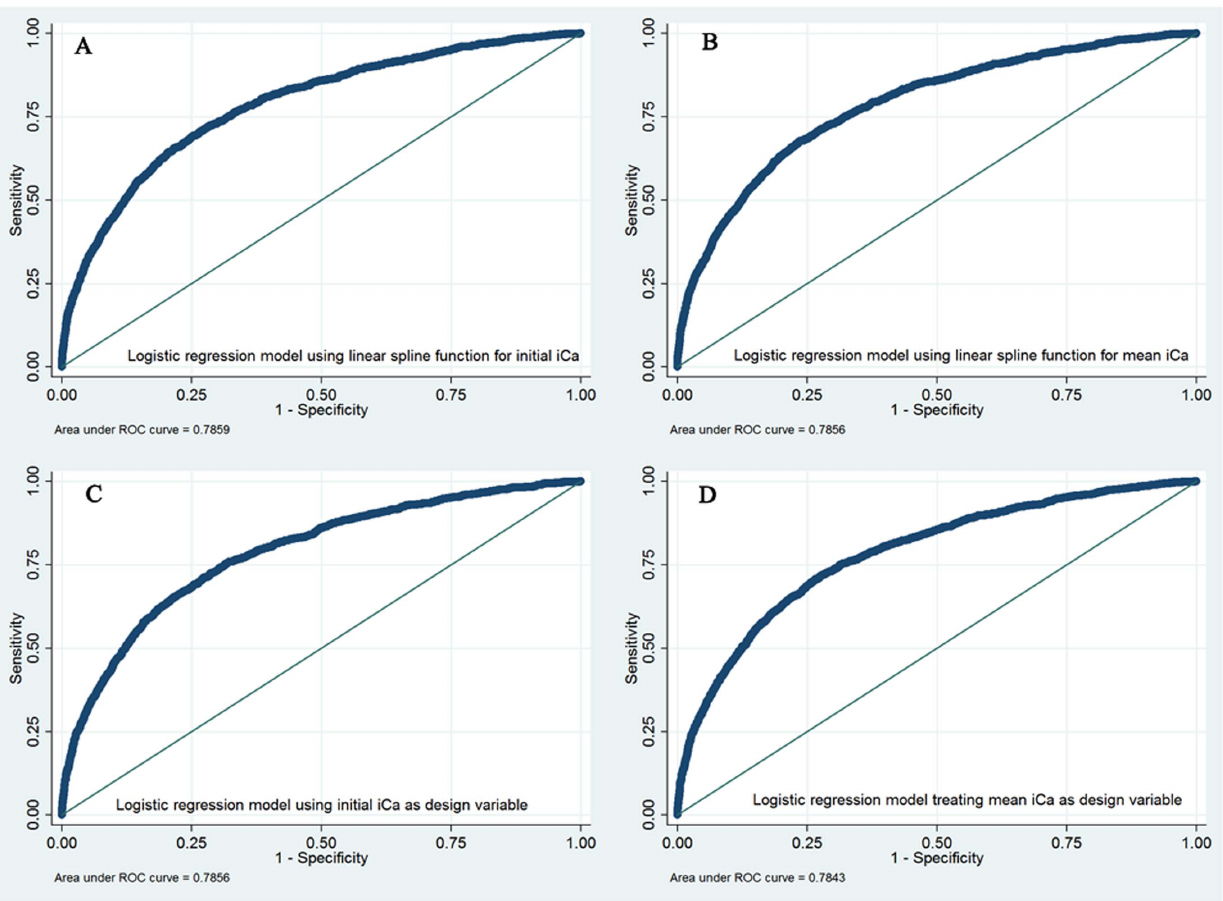
Figure 2. Receiver operating characteristic curve (ROC) shows that the areas under ROC are approximately 0.78 for the four fitted models.